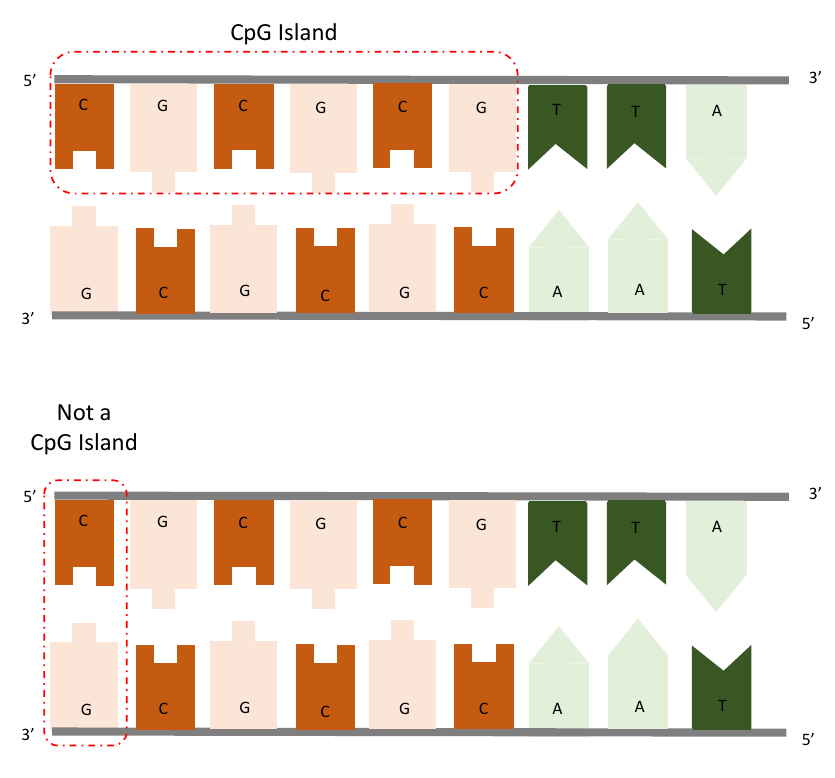
Figure 2. Illustration of CpG